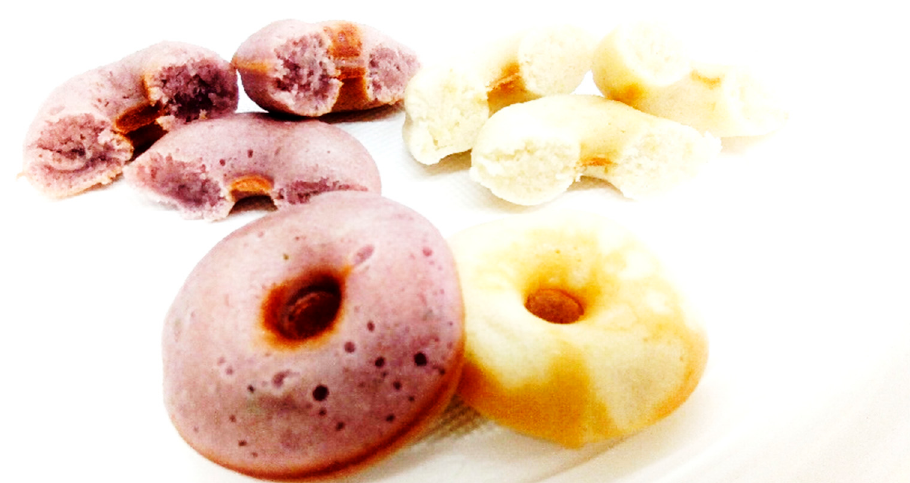
Figure 5. Donuts with an optimal extract rich in anthocyanin compounds (purple donut) and donut controls without the addition of extract (white donuts).